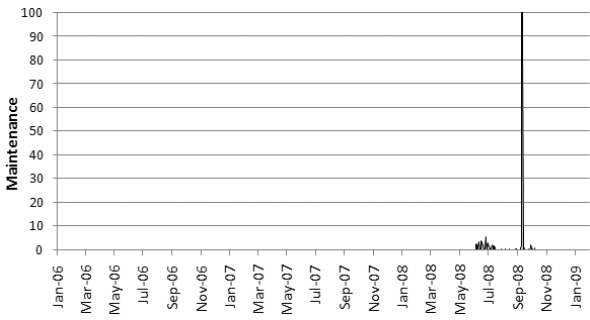
Figure 2. Short-term ( < 6h) failures vs. date.